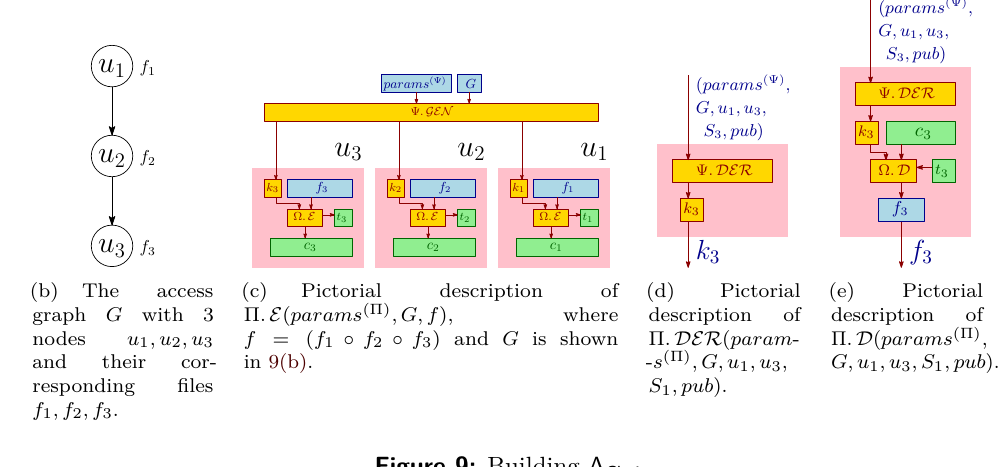
Figure 9: Building A Chain